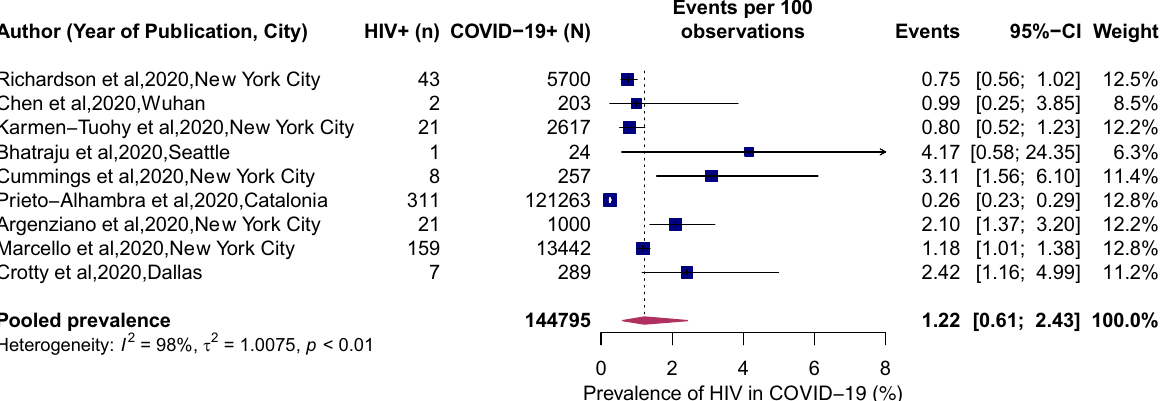
Figure 3. HIV prevalence in populations COVID-19 and the general population. ( A ) Local Prevalence of HIV in cities where COVID-19 studies were conducted. ( B ) Prevalence of HIV in patients hospitalized for COVID- 19. Blue squares and their corresponding lines are the point estimates and 95% confidence intervals per each study. Maroon diamond represents the pooled effect